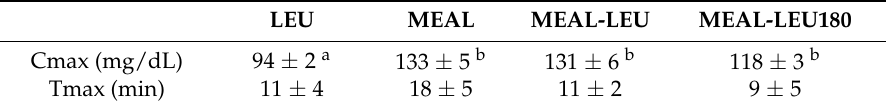
Table 3. Blood glucose concentration of the pharmacokinetics parameters.